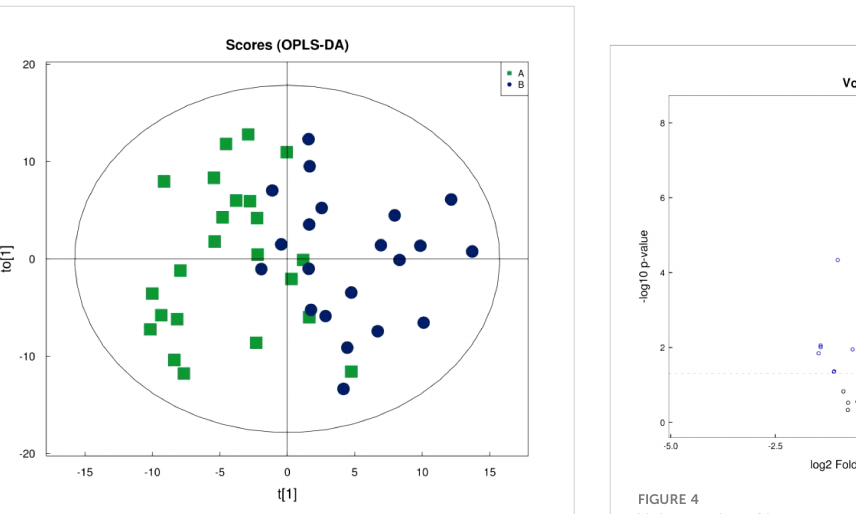
FIGURE 4 Volcano plot of ion pattern in placebo vs. normal control.